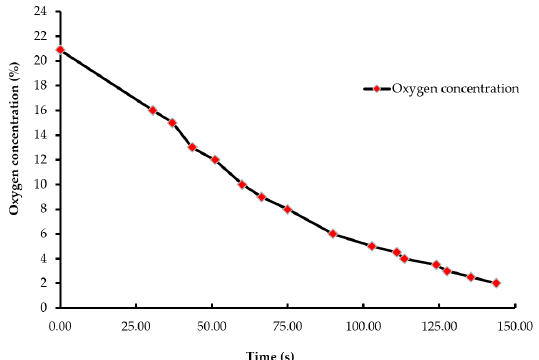
Figure 2. Oxygen wash-out curve (concentration vs. time). The oxygen concentration at the beginning of the treatment was 20.9%, which decreased to less than 2% as the chamber was being filled by nitrogen gas. An electrochemical oxygen sensor measured the oxygen concentration inside the chamber.